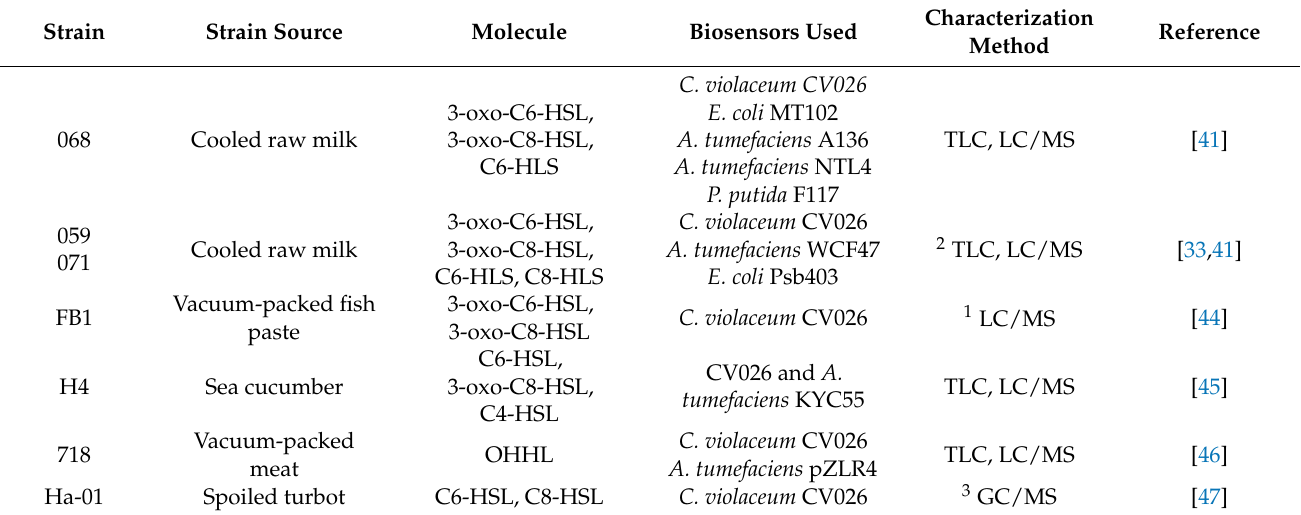
Table 1. Molecules produced by H. alvei strains related to food